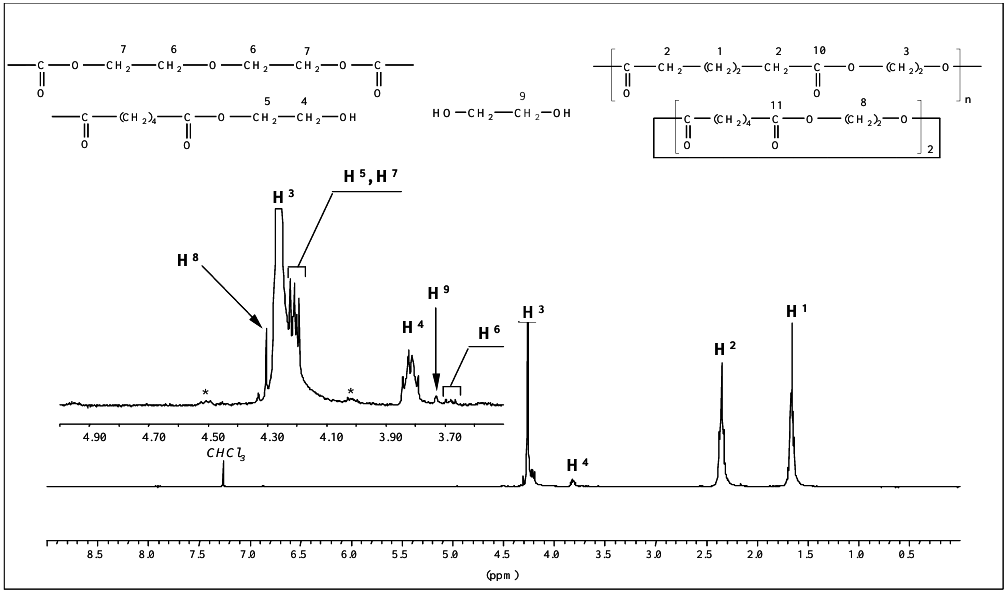
Figure 1. 1 H NMR spectrum of PEA-2 sample in CDCl 3. (* satellite peaks). The 13 C NMR study confirmed the structure of the synthesized polymer (Figure 2).